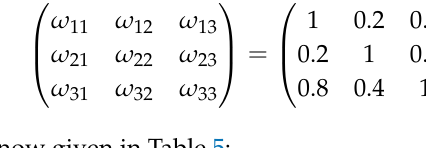
Table 5. Modification of initial correlation coefficients due to the introduction of weights. Coef. Before PSDization PSDized (Initial Weights) PSDization with New Weights ρ 12 − 0.9